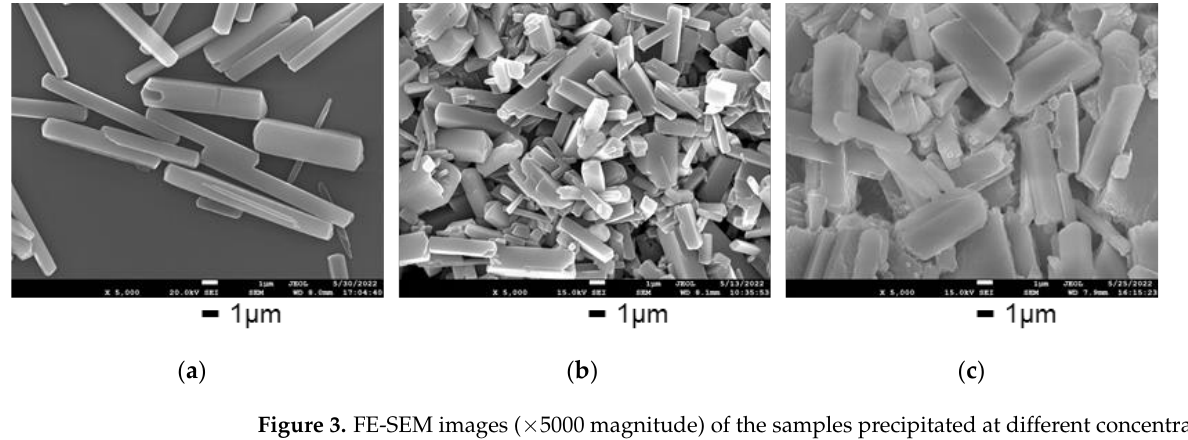
Figure 3. FE-SEM images (×5000 magnitude) of the samples precipitated at different concentrations of ferrous ammonium sulfate ( 𝐶 𝐹𝐴𝑆 ) of 4, 16 and 30 mmol·L − 1 . The oxalic acid concentration and reaction temperature were kept constant at 60 mmol·L − 1 and 25 °C, respectively. ( a ) 𝐶 𝐹𝐴𝑆 = 4 mmol·L − 1 ; ( b ) 𝐶 𝐹𝐴𝑆 = 16 mmol·L − 1 ; ( c ) 𝐶 𝐹𝐴𝑆 = 30 mmol·L − 1 .